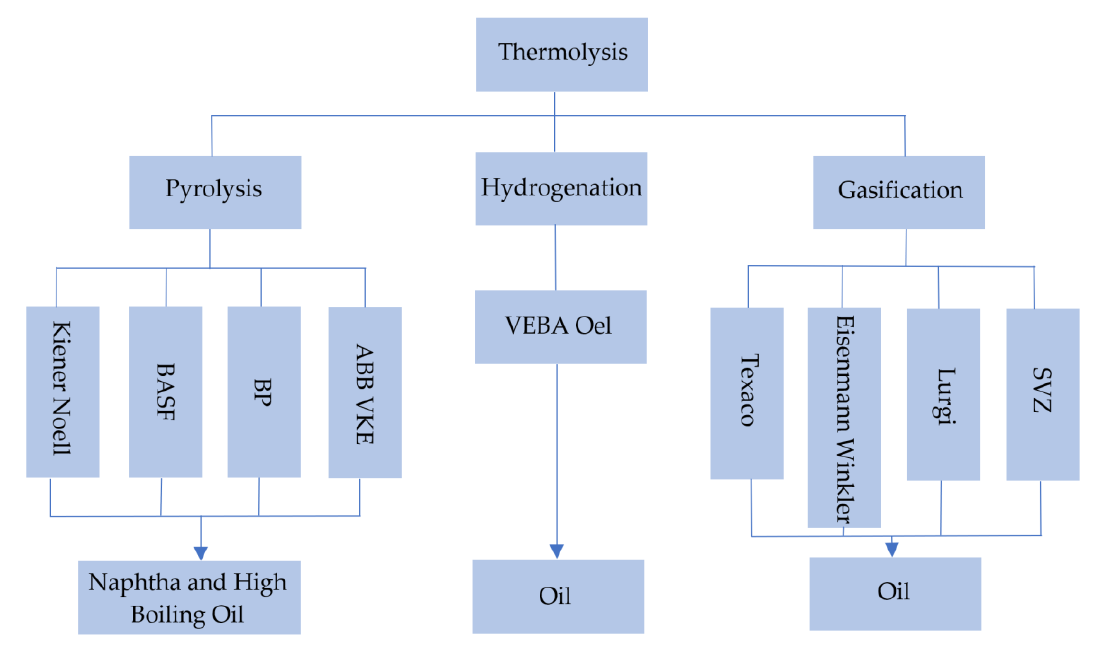
Figure 14. Types of thermolysis. Made based on [24,28].